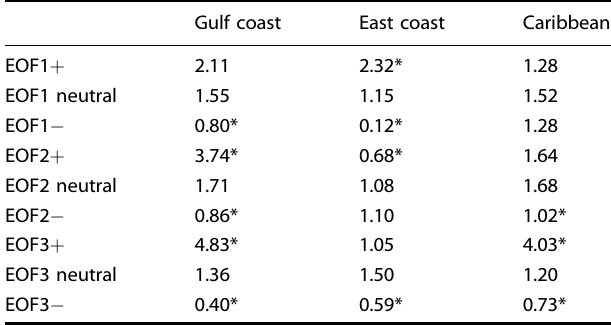
Table 1. TC Landfall rate (per 100 days) during the strong positive (PC > 1), neutral (|PC | < 0.5), and strong negative (PC < − 1) phases of three EOF modes in three regions as shown in Fig.